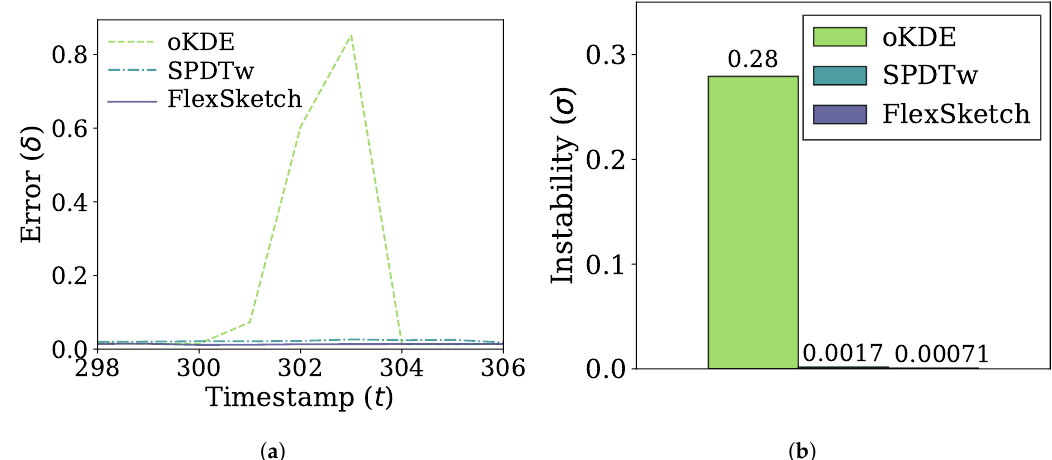
Figure 8. Error and adaptability performance under blip concept drift. ( a ) Change of the error over time. ( b ) Instability (a smaller value is